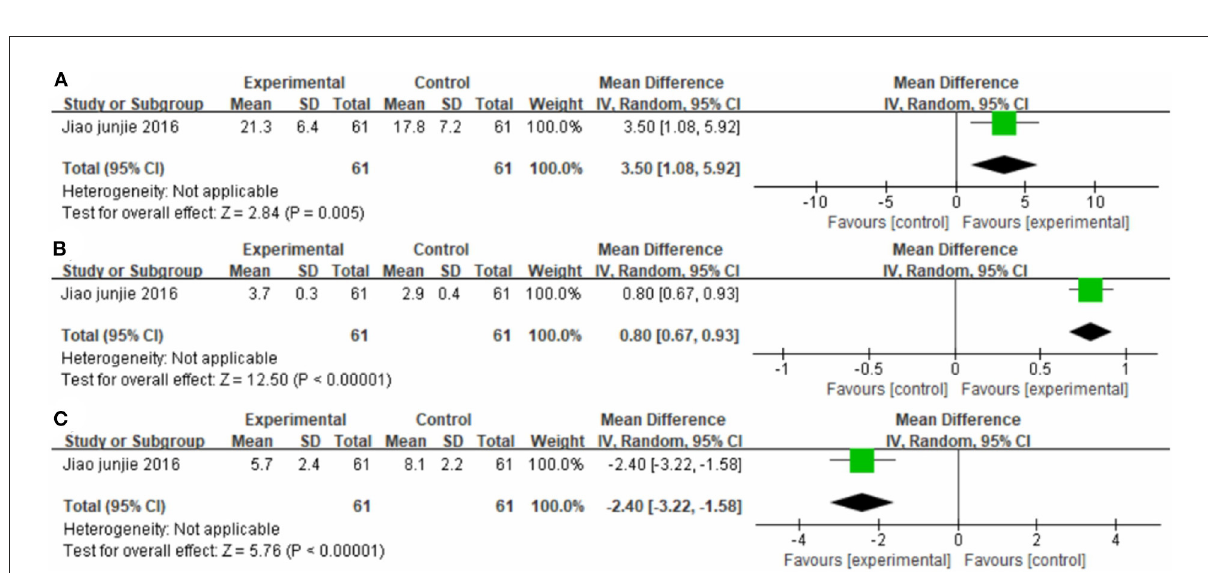
CIMT with device seemed to yield higher FMA-L scores than lower extremity CIMT without device (with device: MD = 4.52, 95% CI 3.65 to 5.38, P < 0.01; with device: MD = 3.37, 95%